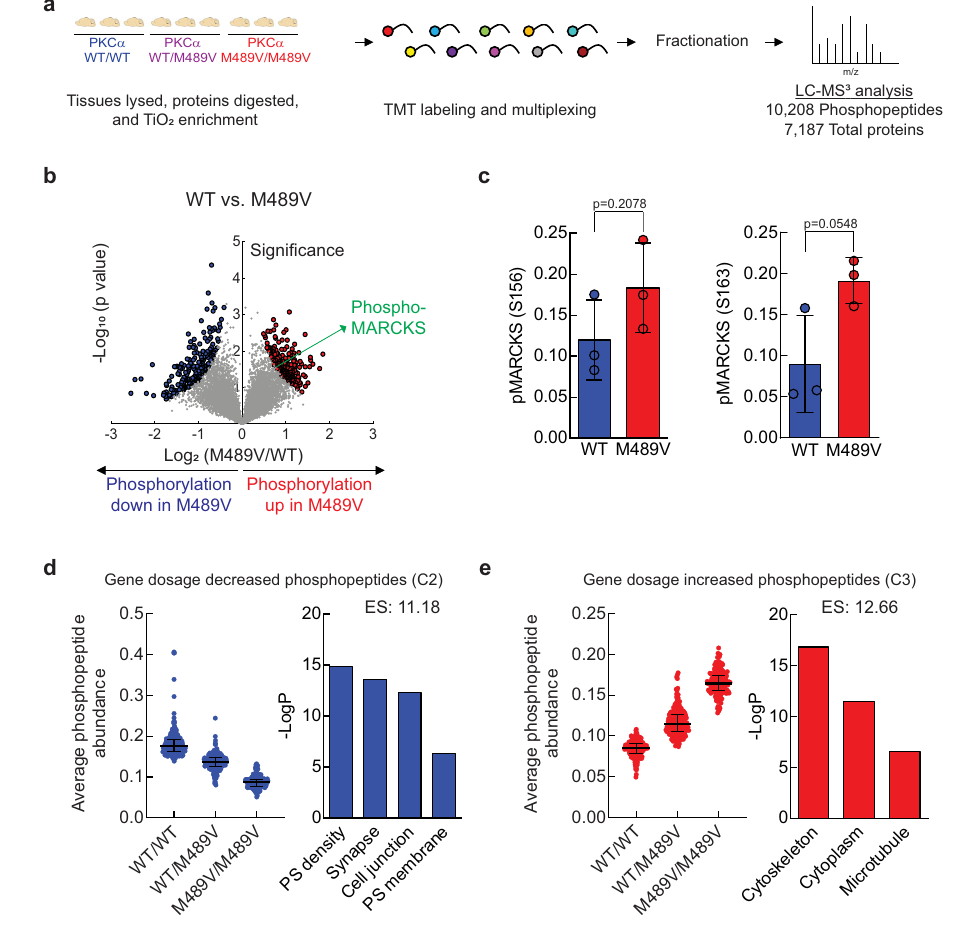
Fig. 1 | Phosphoproteomics analysis of brains from 3-month-old WT mice and mice harboring the PKC α M489V mutation on C57BL/6 background. a Experimental design. Brains from WT (blue), heterozygous (purple), or homo- zygous (red) mice were subjected to phosphoproteomics analysis. 7187 proteins and 10,208 phosphopeptides were quanti fi ed per sample in the standard pro- teomics and phosphoproteomics analyses, respectively. b Volcano plot of phos- phopeptides quanti fi ed from brains from WT mice and M489V homozygous mice. The − log 10 -transformed p values associated with individual phosphopeptides are plotted against the log 2 -transformed fold change in abundance between WT and M489V homozygous brains. Color intensities depict peptides whose phosphor- ylationlevelissigni fi cantlyhigher(red)orlower(blue)inM489Vhomozygousmice comparedtoWT.Signi fi cancewasdeterminedatapiscorecutoffof α <0.05,and p valuesforcalculatingpiscoresweregeneratedwithatwo-tailedStudent ’ s t testnot corrected for multiple hypotheses. c Graph showing the quanti fi cation of two